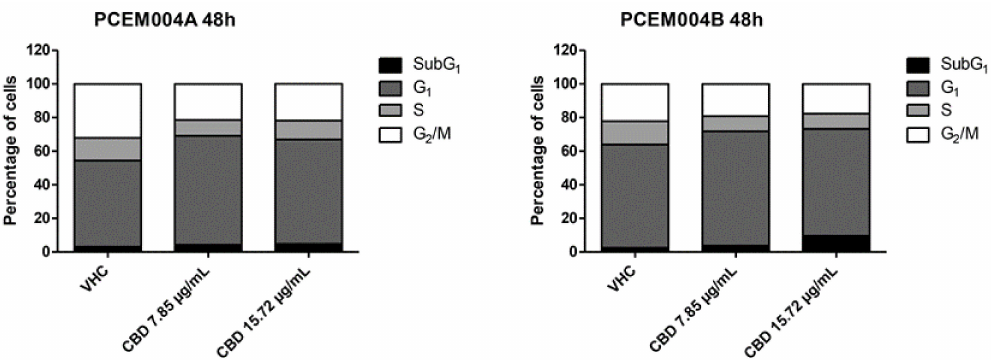
Figure 10. CBD induced cell cycle arrest in PCEM004 EC cell lines. PCEM004a and PCEM004b EC cell lines were treated with CBD up to 15.72 µ g / mL for 48 h. Percentage of cells are represented as histogram representations of the cell cycle phases in the EC cell lines and are representative of one of three separate experiments.